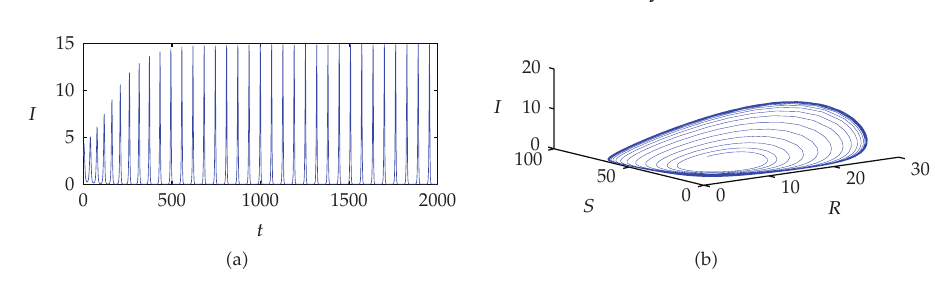
Figure 1: Temporal behavior of the infected and corresponding three-dimensional phase are plotted for the system (cid:2) 1.1 (cid:3) subject to R 0 > R cc (cid:2) R 0 (cid:8) 4 . 00, R cc (cid:8) 3 . 00 (cid:3) . The parameters are r (cid:8) 0 . 1, K (cid:8) 80, β (cid:8) 0 . 1,